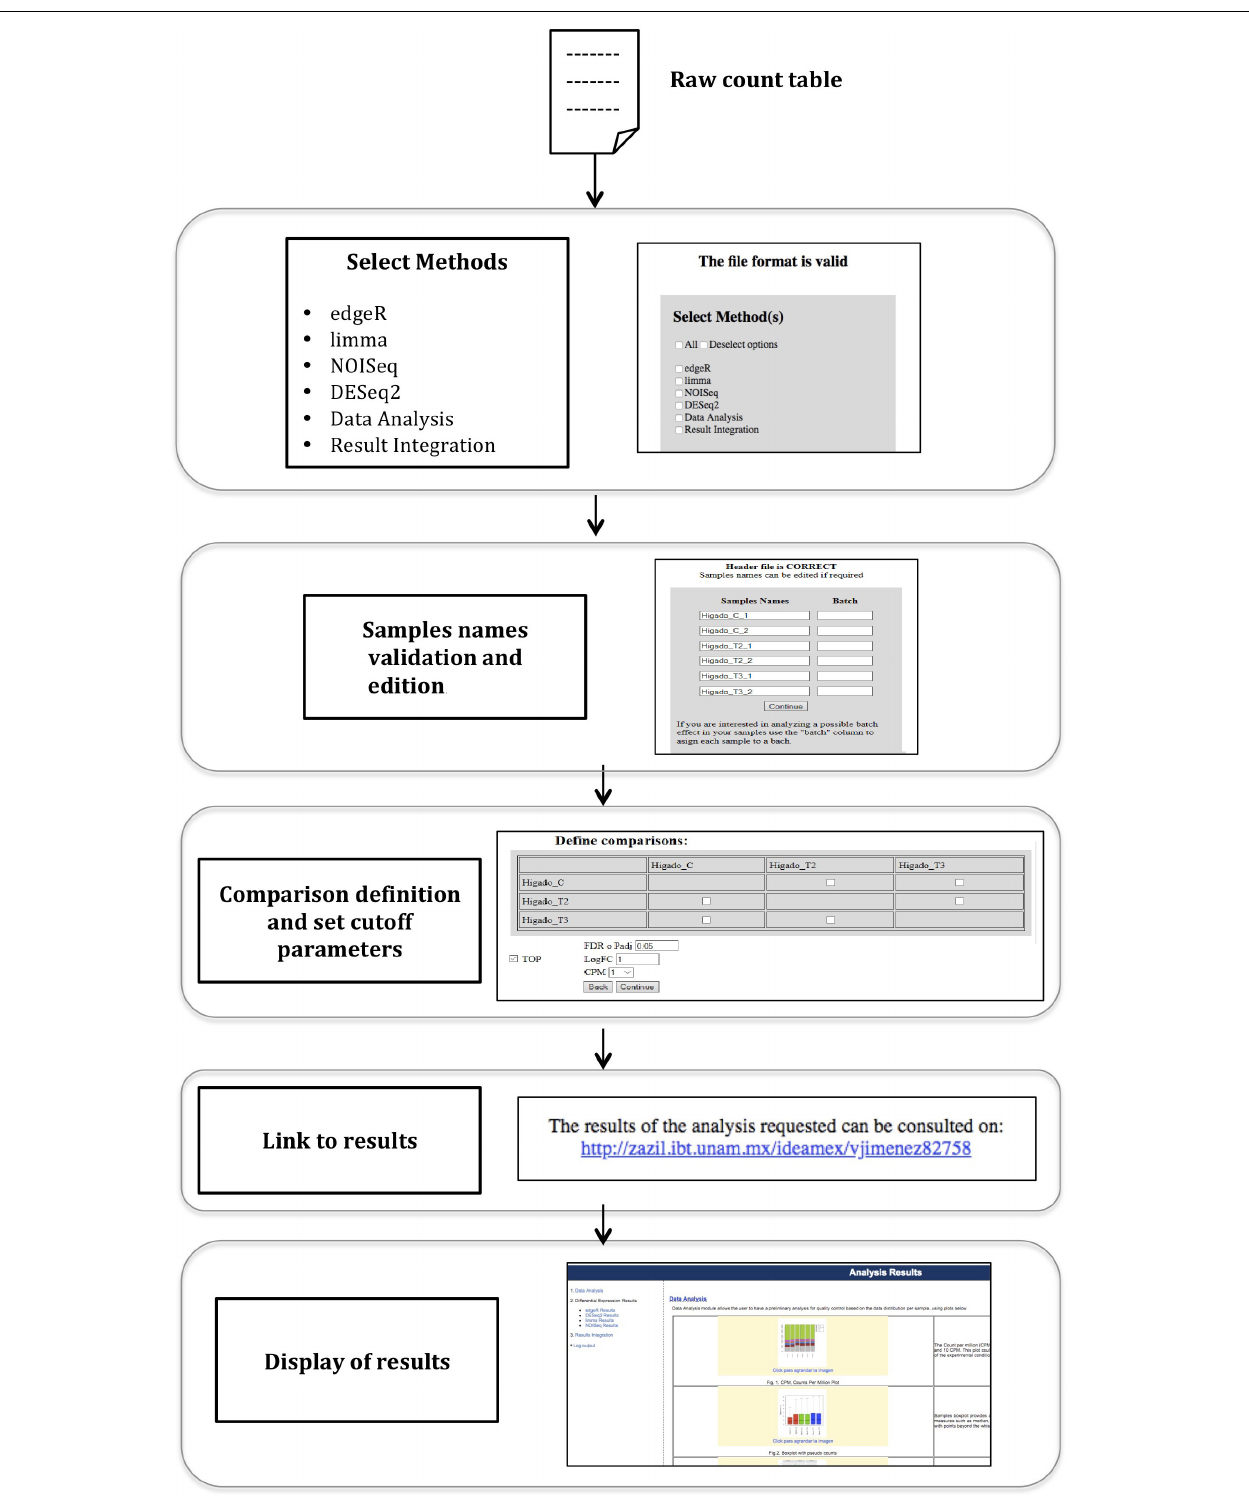
FIGURE 1 | IDEAMEX workflow diagram. The web server workflow starts with the loading and validation of the raw count table as input. Then, the user selects one or more methods for differential expression analysis, data analysis and results integration. An optional step to edit the sample names is available. The user designs the comparison matrix by selecting which conditions will be compared. A link to the results is generated and after a few minutes, the results are presented in the Analysis Results web page.